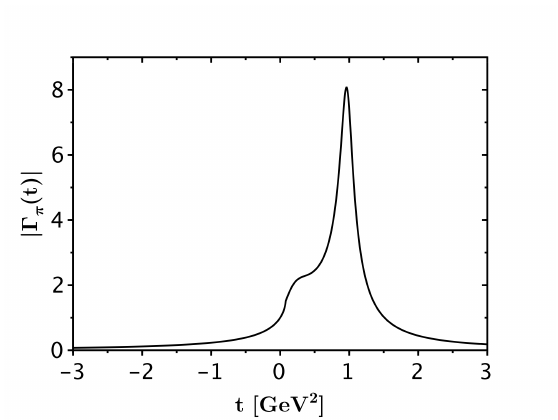
Figure 3. Behavior of the pion scalar form factor (20) with one zero and four poles at − 3GeV 2 < t < 3GeV 2 . Results correspond to a fit to the output phase shifts from [3] by 5 free parameters. Physically may be interpreted region only below 990 MeV ( t ≈ 0 . 98 GeV 2